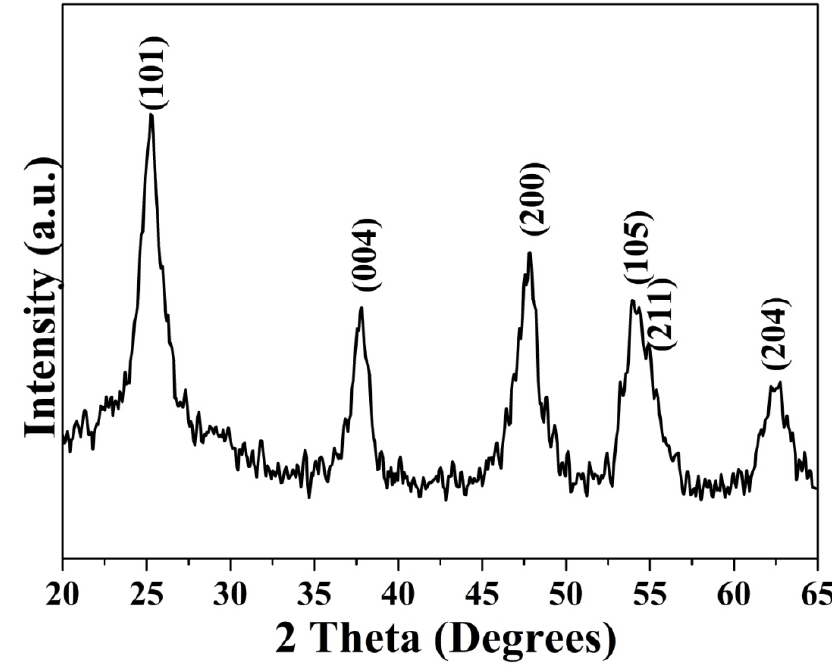
Figure 2. XRD pattern of TiO 2 nanoparticles.